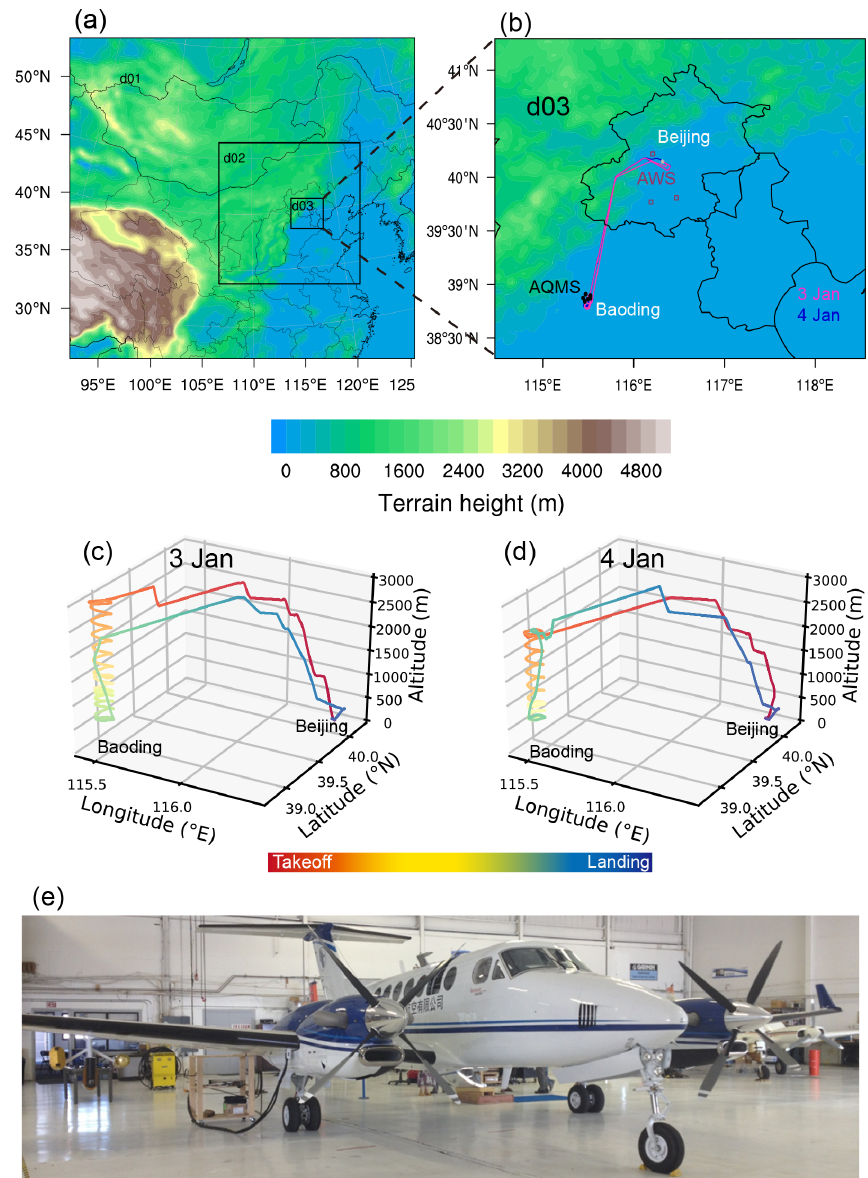
Figure 1. WRF-Chem domains with the terrain height and flight routes. (a) The outermost domain (d01) and the two embedded domains (d02 and d03). (b) The innermost domain (d03). (c–d) The three-dimensional flight routes on 3 and 4 January 2020, respectively. (e) The King Air 350 aircraft. The black dots and brown boxes in panel (b) show the locations of the air quality monitoring sites (AQMSs) and automatic weather stations (AWSs), respectively. The red and blue lines (overlain) in panel (b) represent the horizontal flight routes on 3 and 4 January 2020,